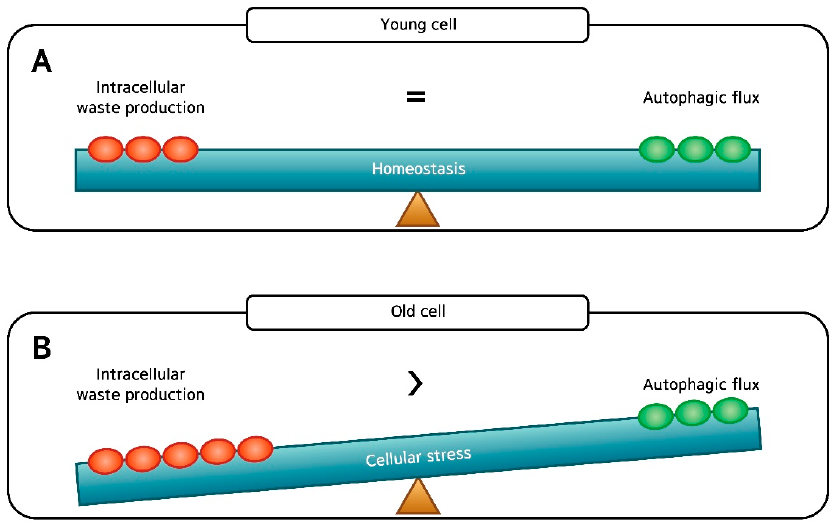
Figure 7. ( A ) There is good balance between “intracellular waste production” and “autophagic